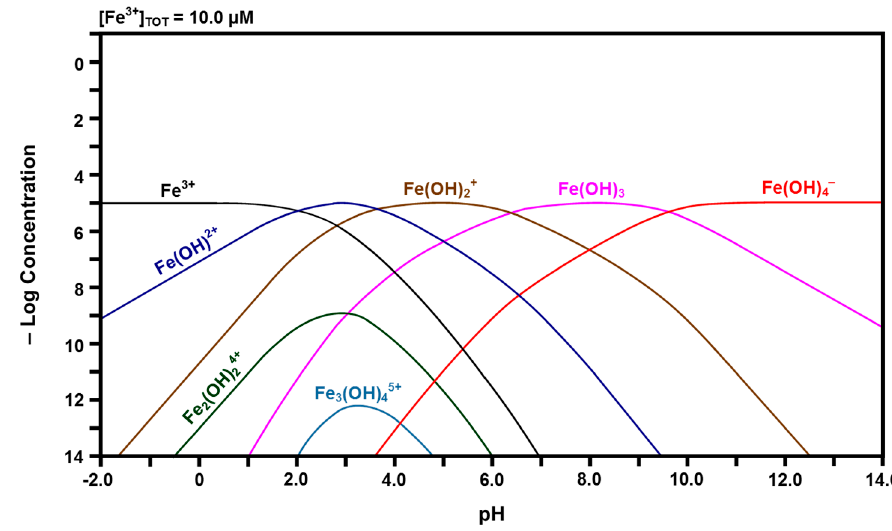
Figure 6. Calculated speciation diagram of Fe 3+ -H 2 O.